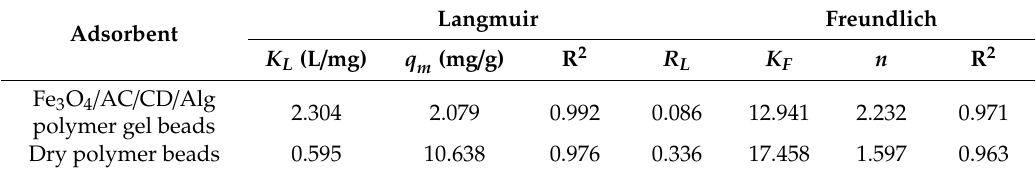
Table 3. Equilibrium isotherm parameters of removal of MB by Fe 3 O 4 / AC / CD / Alg polymer gel beads and dry polymer beads. Adsorbent